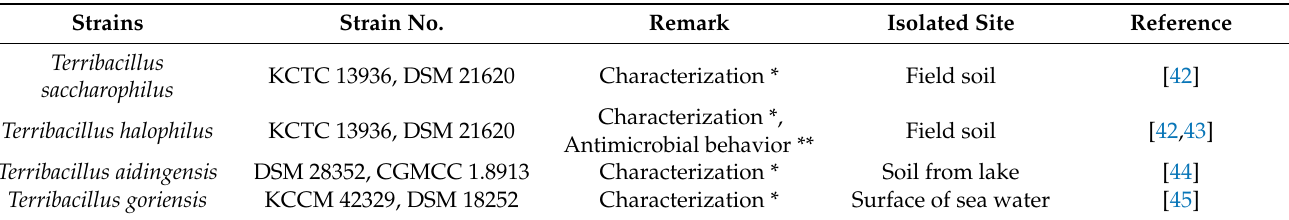
Figure 2. Phylogenetic tree of Terribacillus sp. JY49 according to 16S rRNA sequencing. Table 2. List of previously reported Terribacillus